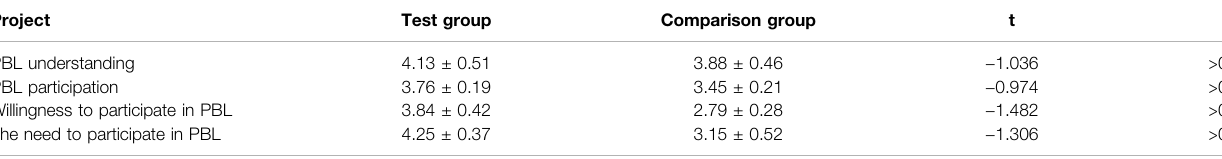
TABLE 2 | Comparison of cognition and attitude of internship in PBL.